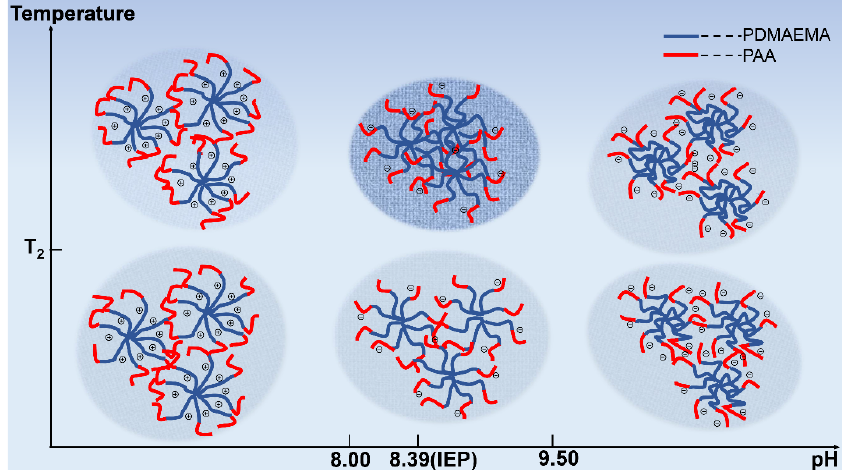
Figure 6. Schematic diagram of the pH- and thermo-response of the star-like PDMAEMA 4 - b -PAA 1 solution.